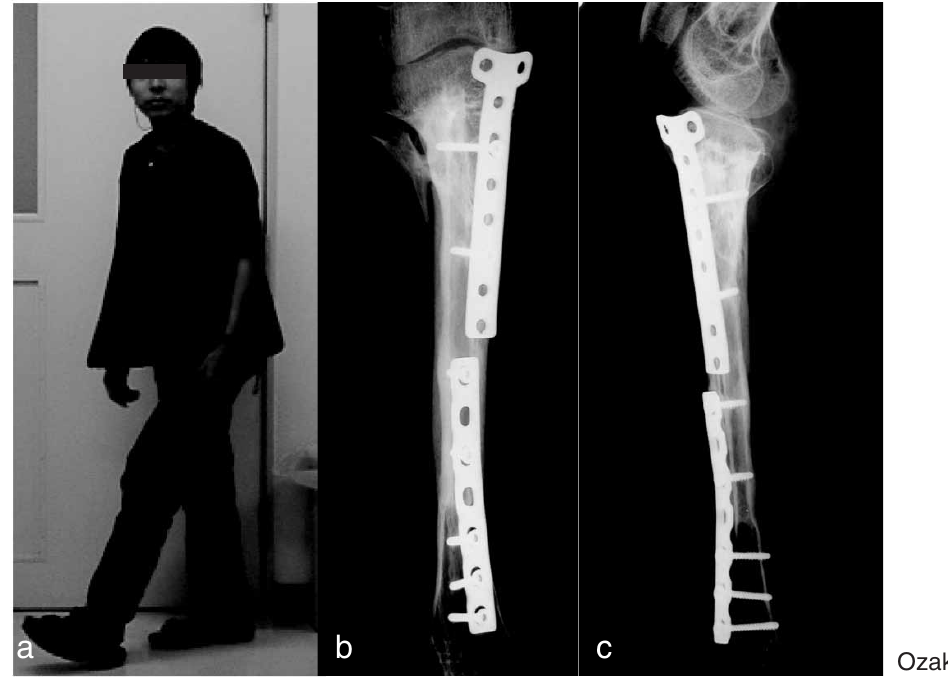
Fig. 5. Case 2 . Five years after operation. (a) The patient, a high-school student at age 17 years, is shown using the knee brace. However, he can walk without further external supports. (b) Anterior-posterior view of plain radiograph. (c) Lateral view of plain